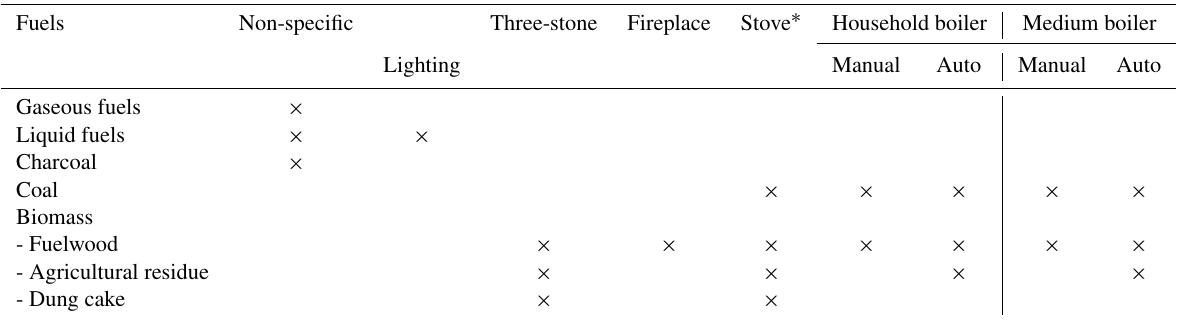
Table 2. Residential–commercial sector fuel and source structure in GAINS. The cross indicates the combinations defined in the GAINS model. Fuels